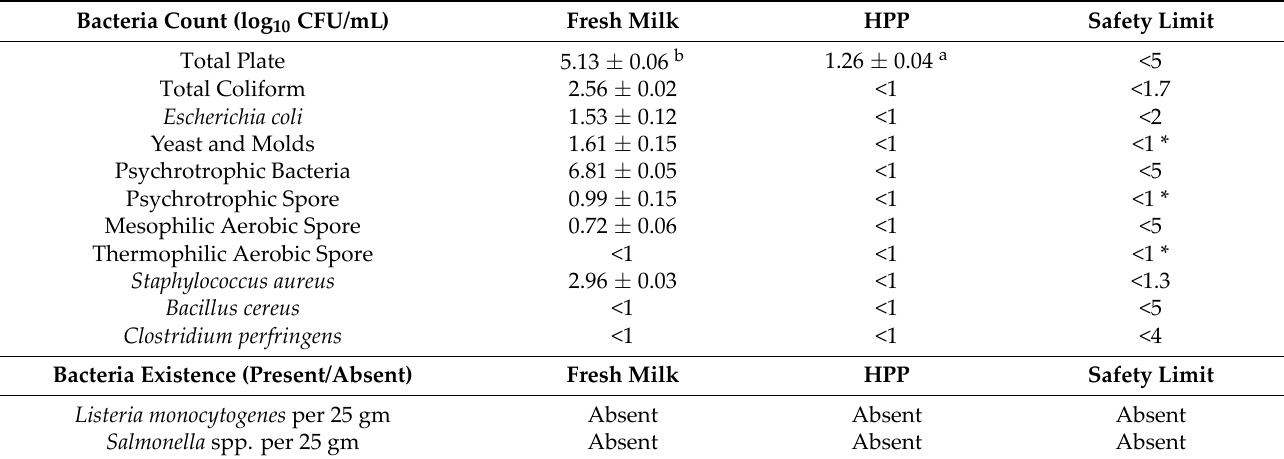
Table 1. Effects of HPP on microbiological properties of fresh